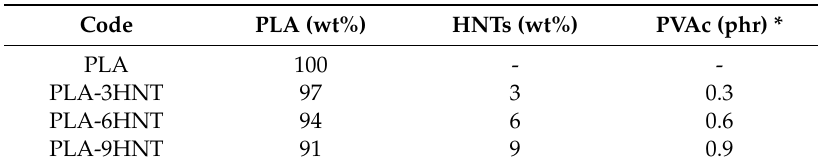
Table 1. Poly(vinyl acetate)—PVAc was obtained from Sigma-Aldrich (Madrid, Spain), it was used as a compatibilizer due to its high hydrophilicity. Table 1. Labeling and composition of poly(lactic acid) composites with di ff erent HNTs loadings with poly(vinyl acetate)